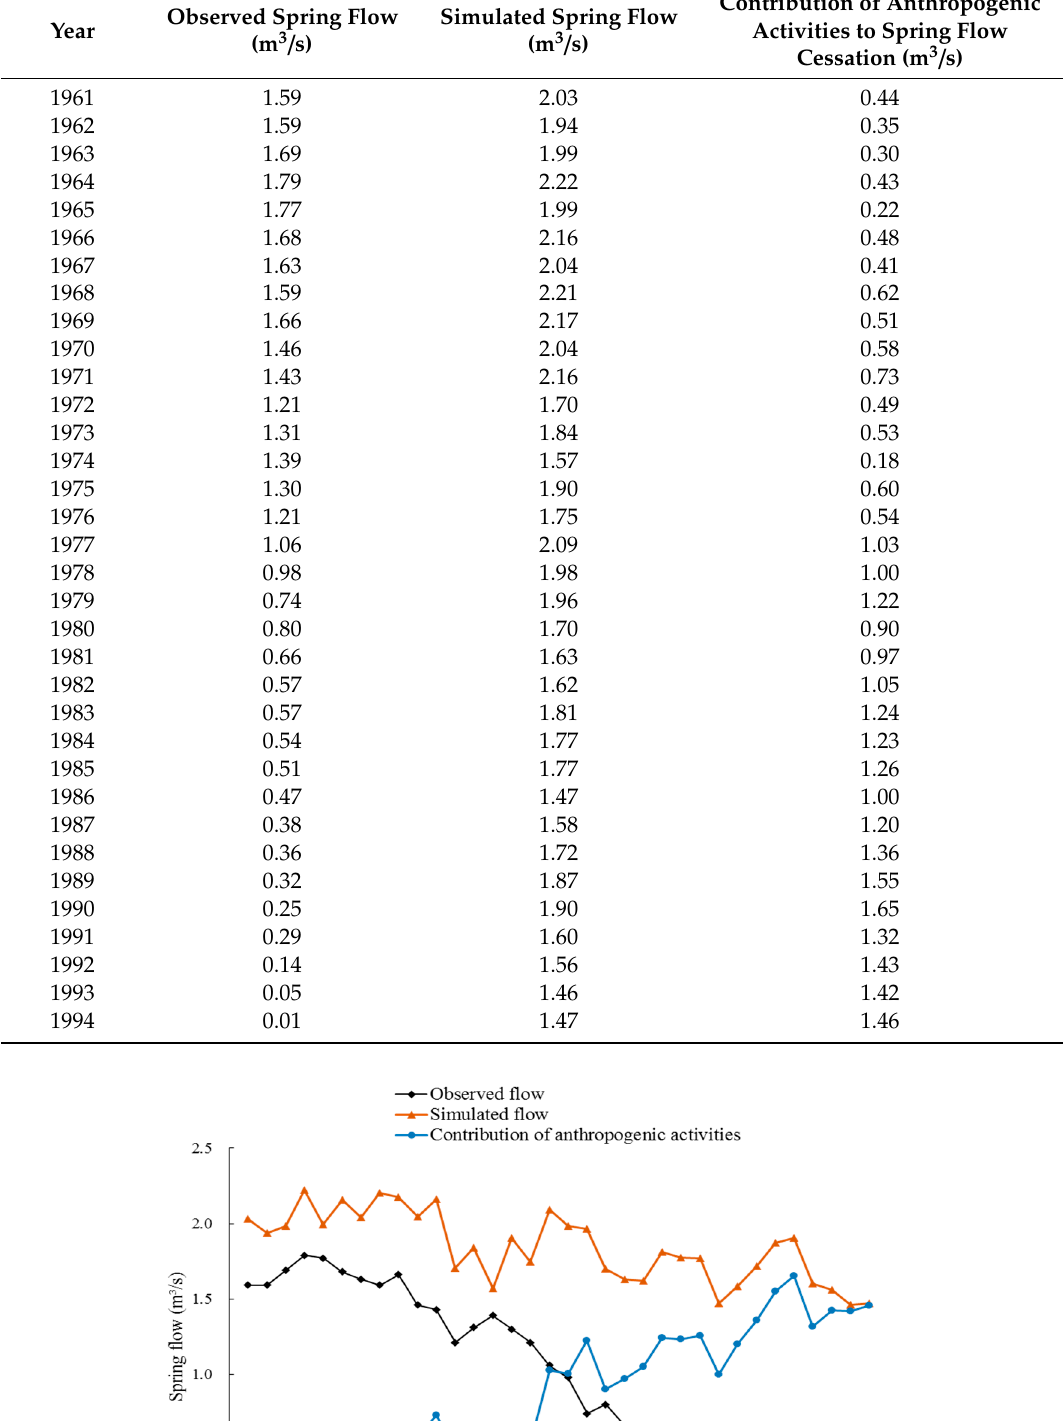
Table 4. Contribution of anthropogenic activities to the drying up of Jinci Springs.